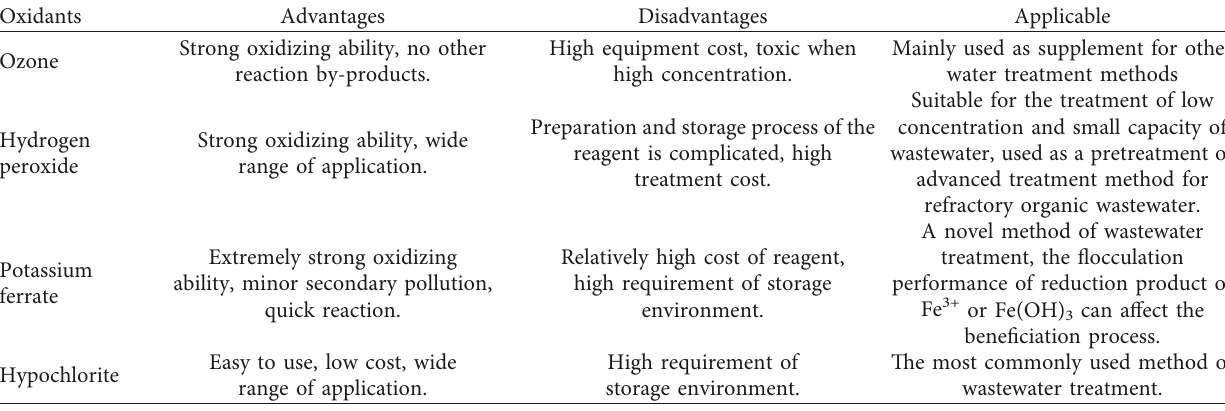
Table 1: Simple comparison of common